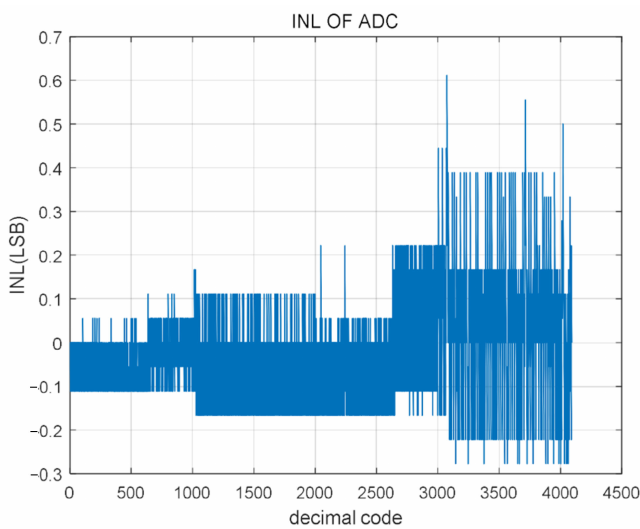
Figure 9. Simulation test results of